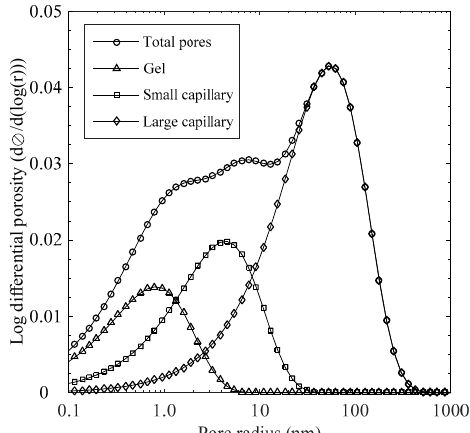
Figure 1. Calculated pore size distributions for each pore component together with overall pore size distribution. Simultaneously, under a thermodynamic equilibrium, the degree of saturation in concrete depending on relative humidity level was determined using the moisture iso- therms for vapor adsorption and desorption, as shown in Figure 2. As relative humidity increases, saturation radius increases to raise overall water content with pore sizes up to 1000 nm, over which porosity increment is negligible. Also, the degree of saturation for vapor adsorption rapidly increases up to 1.0 nm in pore radius and gently with pore size up to about 4.0 nm, over which capillary condensation become again promoted due to the high portion of large capillary pore. The degrees of saturation under drying are consist- ently higher than those for vapor adsorption by the amount of entrapped water content where the pores bigger than saturation pore radius are partially saturated. Hence, under the cyclic exposure condition, a surplus amount of moisture due to the moisture entrap- ment under drying can resist a sudden drop of moisture level through the concrete cover.